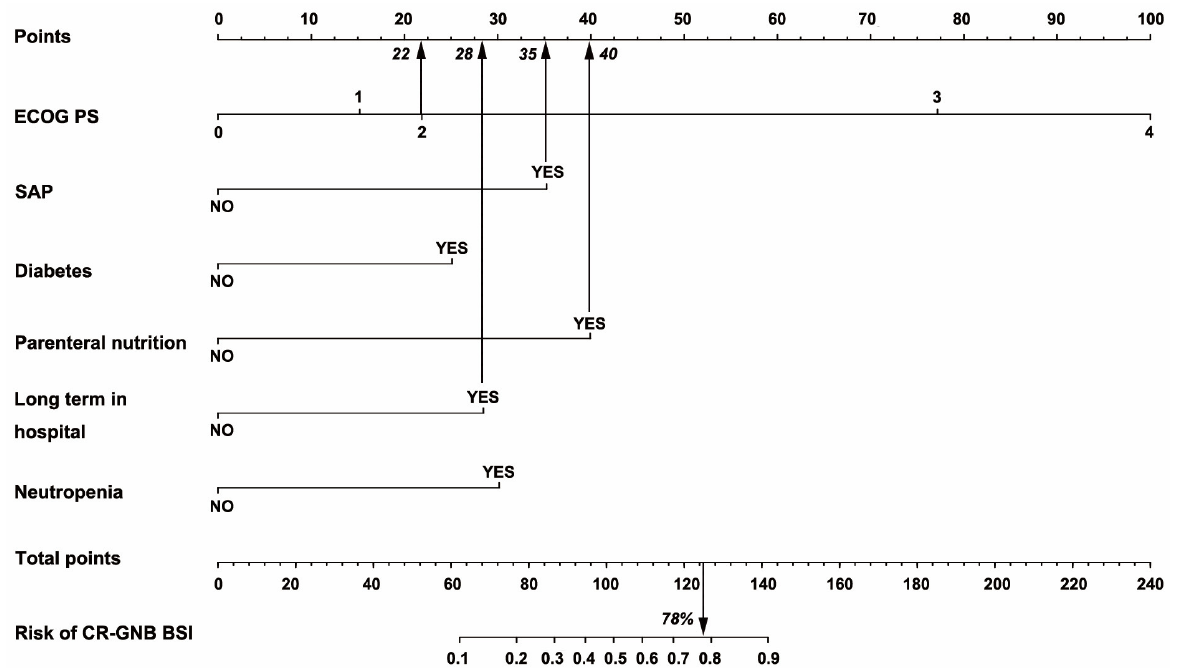
Figure 2. Nomogram for predicting the probability of secondary CR-GNB BSI for carrier patients in GED. Abbreviations: ECOG (Eastern cooperative oncology group score); SAP (severe acute pancre- atitis); CR-GNB (carbapenem–resistant Gram–negative bacteria); BSI (blood stream infection).